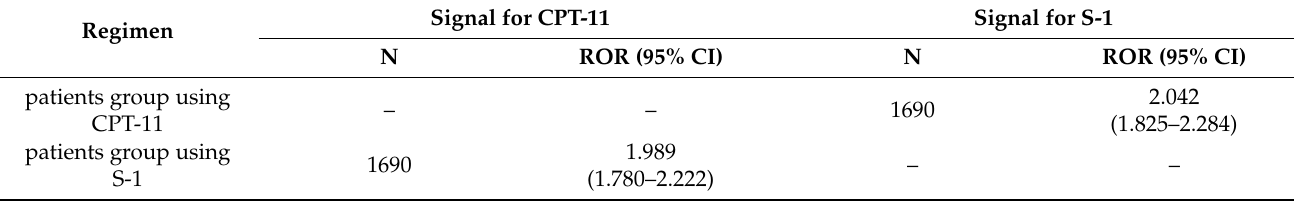
Table 3. Diarrhea induced by irinotecan (CPT-11) and S-1 due to drug–drug interaction.